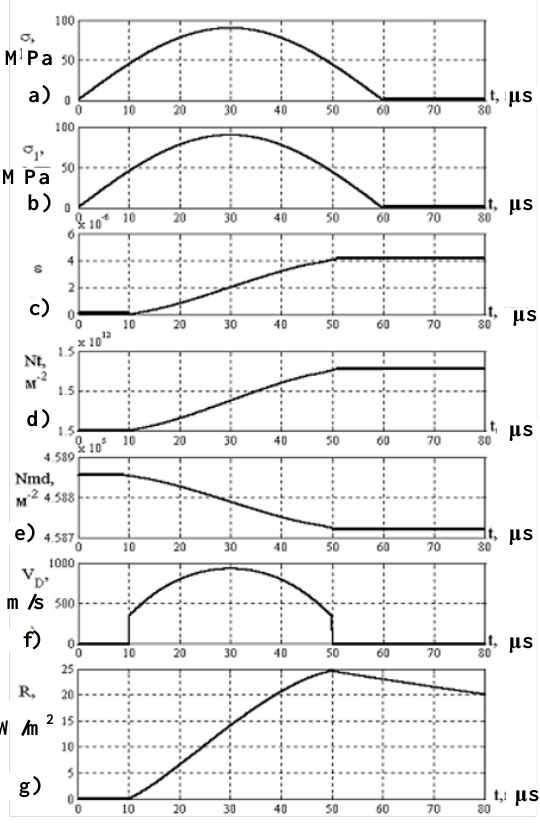
Fig. 1. An example of calculating the dislocation parameters of plastic deformation as a function of time: a - pressure pulse; b - current stress; c - total deformation; d - average total density of dislocations; e - average density of moving dislocations; f - average speed of dislocations; g - output uls of n rgy luminosity (constant att nuation tim 5 μs; ra iation wav l ngth λ 58